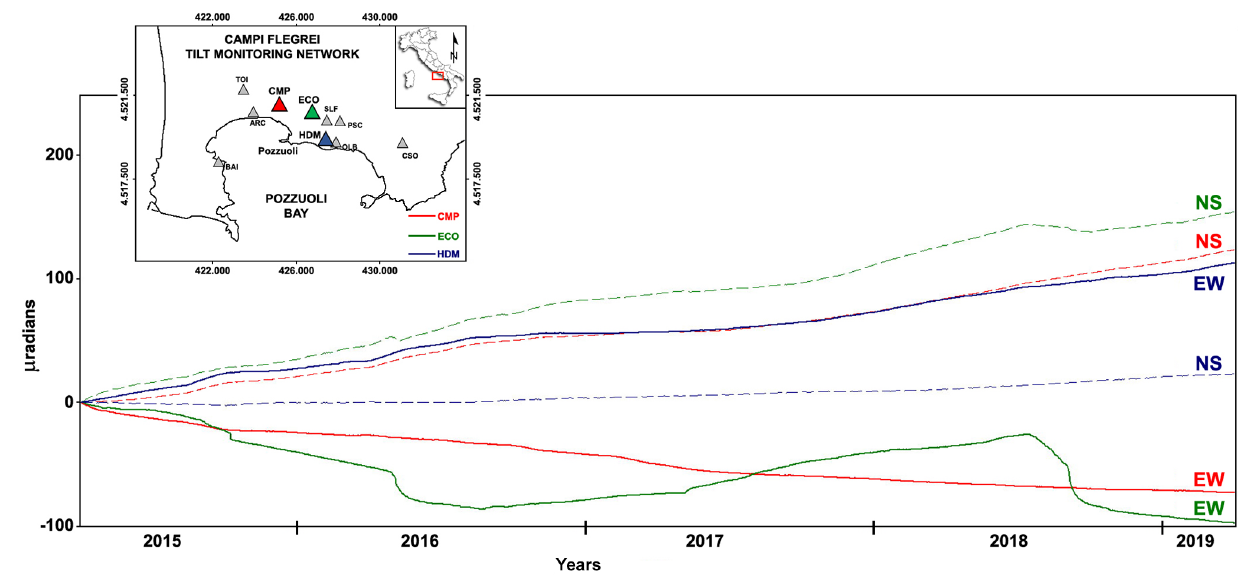
Figure 1. Map of the tiltmeter network at Campi Flegrei and ground tilt (raw signal) recorded in four years at CMP, ECO and HDM instruments. The colours identify the different sensors, dashed and continuous lines indicate the NS, EW components,